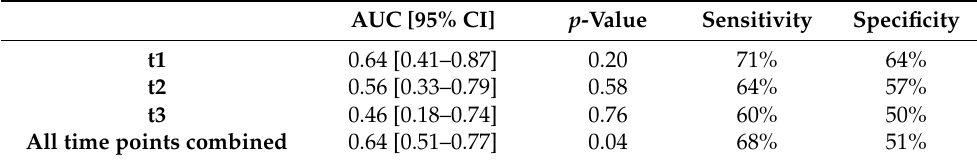
Table 2. Results fecal VOC analysis on different time points.